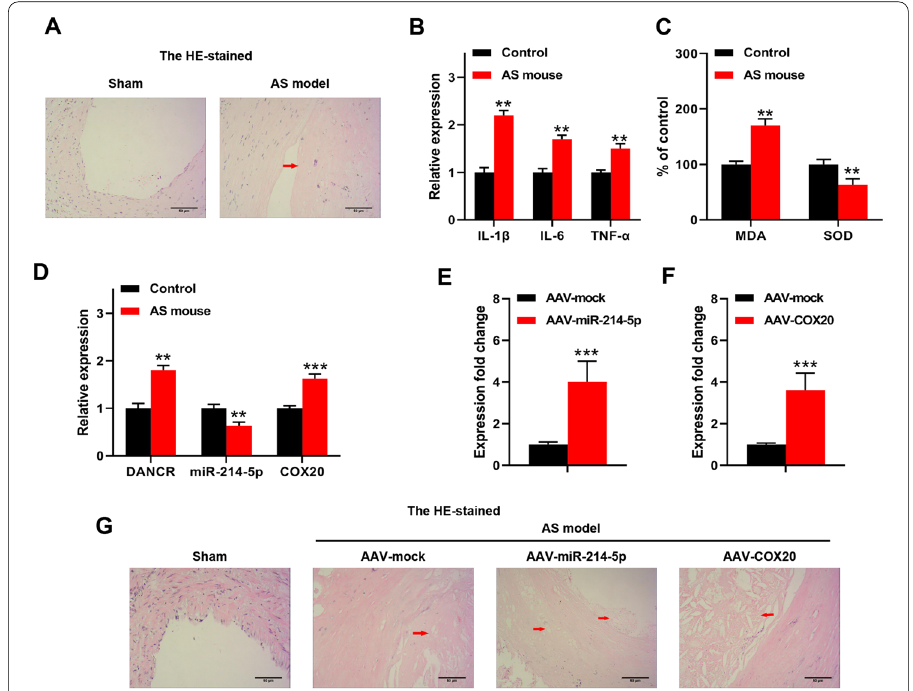
Fig. 6 DANCR/miR-214-5p/COX20 participated in development of AS in vivo. A Representative micrographs of the lesion areas in the aortic sinus were observed by H&E staining at 400 magnification, scale × bar 50 μm. B , C Levels of inflammatory cytokines ( B ), MDA, and SOD ( C ) in blood samples of AS animal = model were detected by specific detection kits. D Expression of DANCR, miR-214-5p, and COX20 in blood samples of AS animal model was evaluated by qRT-PCR. E , F Adenovirus overexpressing miR-214-5p and COX20 were injected into mice, and expression of miR-214-5p ( E ) and COX20 ( F ) in blood samples of AS animal model was evaluated by qRT-PCR. G Representative micrographs of lesion areas in the aortic sinus were observed by H&E staining. 400 magnification, scale bar 50 μm. There were six mice in each group. × = Each experiment was repeated three independent times. **p < 0.01 and ***p <